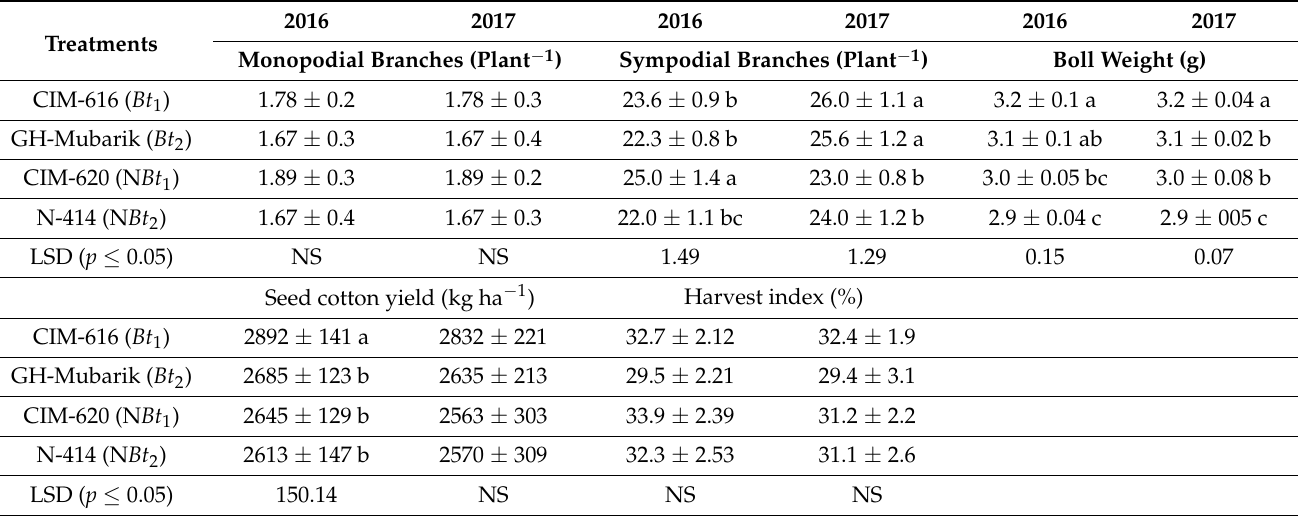
Table 5. The influences of different Bt and non- Bt genotypes on yield-related attributes of cotton crop.